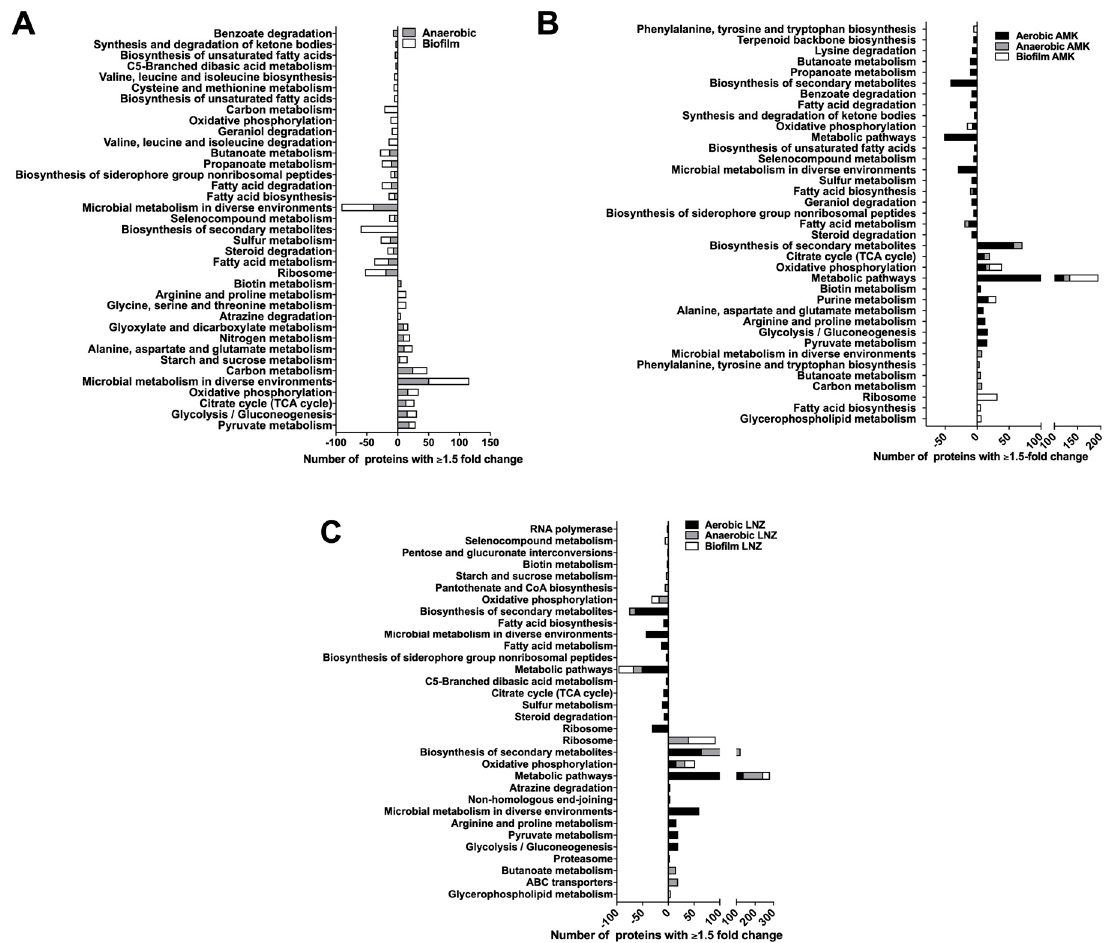
Figure 6. Metabolic pathway enrichment. Proteins were grouped based on the KEGG pathway database for enriched and repressed proteins in ( A ) anaerobic and biofilm, ( B ) AMK treated aerobic, anaerobic and biofilm, and ( C ) LNZ treated aerobic, anaerobic and biofilm experimental groups.